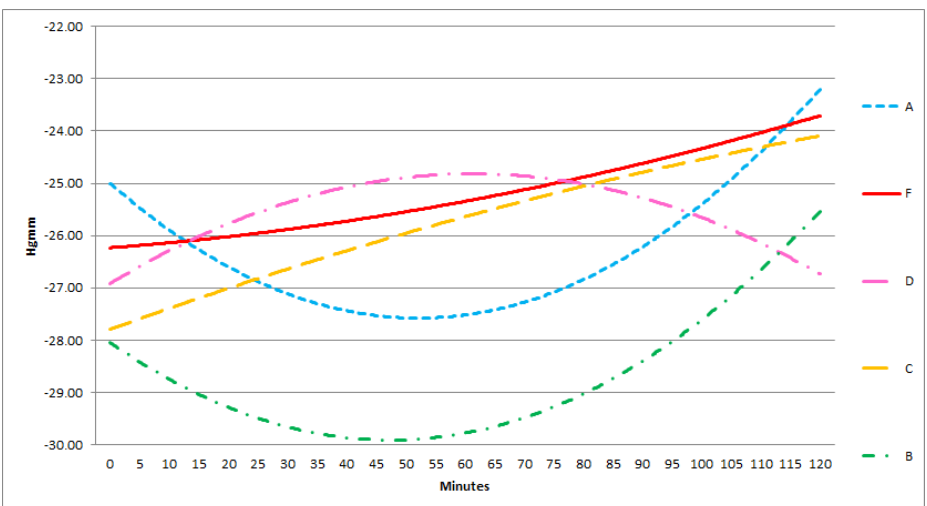
Figure 6. Results of statistical (correlation) analysis between the different sensor pairs during NPWT applying at 50 mmHg suction. The pressure values and their changes in time was measured by different sensors at −50 mmHg NPWT. Sensors represent exact measurement points in the abdominal cavity. (The pressures at sensors A–F are presented enlarged also. A: midline, above the layer; B: midline, under the layer; C: laterally, above the layer; D: laterally, under the layer; E: midline, among the bowels; F: laterally, among the bowels.)